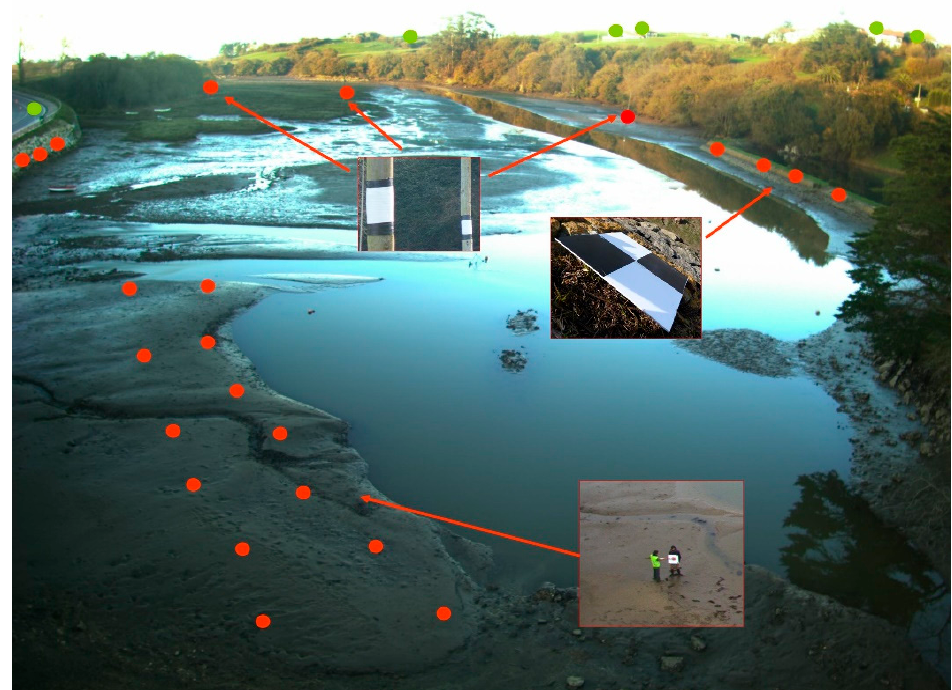
Figure 8. Points of selected field controls for Camera 3.